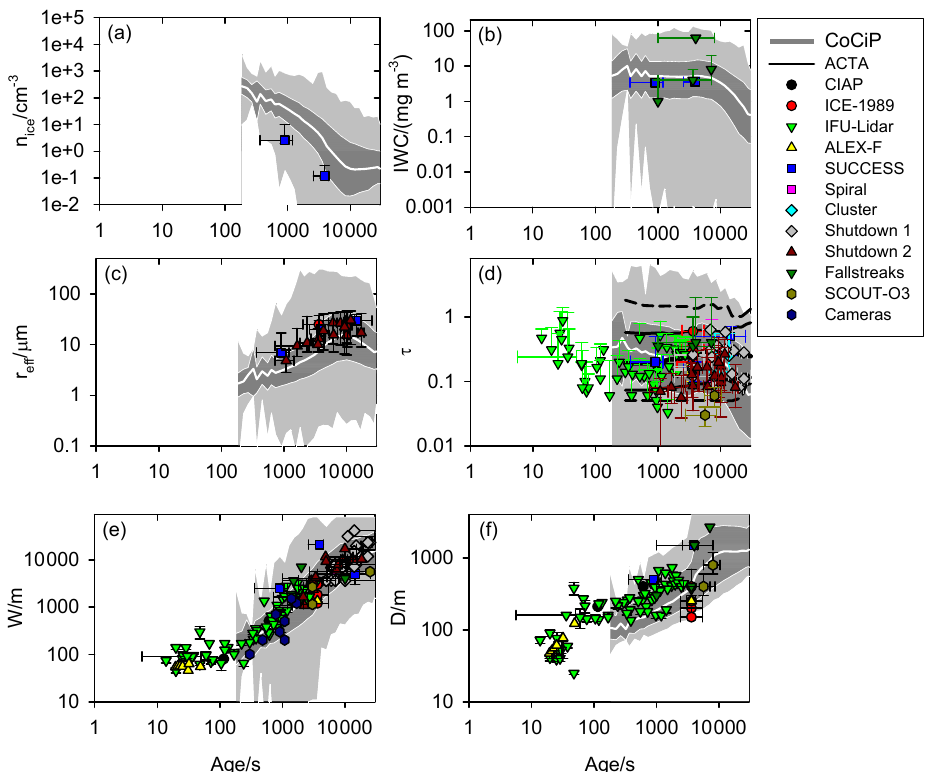
Figure 2. Same as Fig. 1 for remote sensing data. (a) n ice , (b) IWC, (c) r eff , (d) optical depth τ at solar wavelengths, (e) W , and (f) D . The black lines in panel (d) depict mean values of optical depth τ derived from 25600 ACTA results (0th, 10th, 50th, 90th, 100th percentiles).